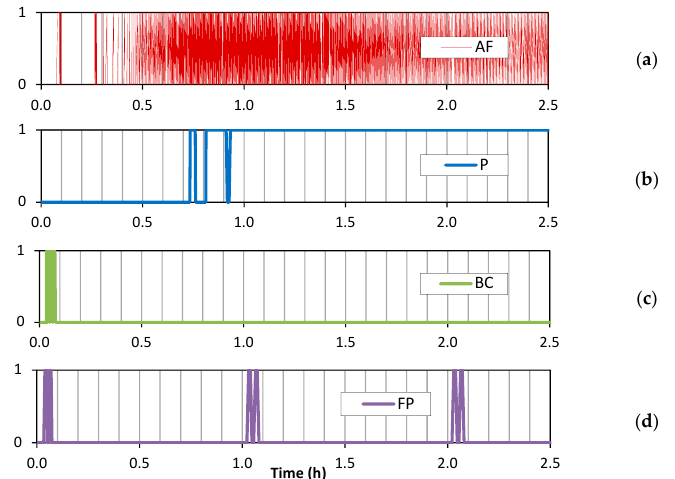
Figure 2. Boiler operation elements during combustion test of COM pellets. ( a ) Auger feeder; ( b ) pump; ( c ) burner cleaning system; and ( d ) fume pass cleaning system.